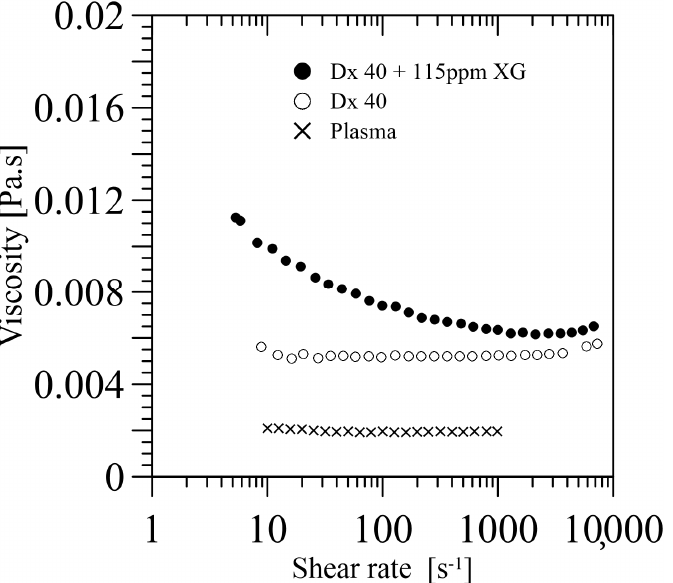
Figure 8. Steady shear viscosity curves as a function of the shear rate obtained by Brust et al. [24] for blood plasma, and Pinho et al. [55] for Dx40 and Dx40+115